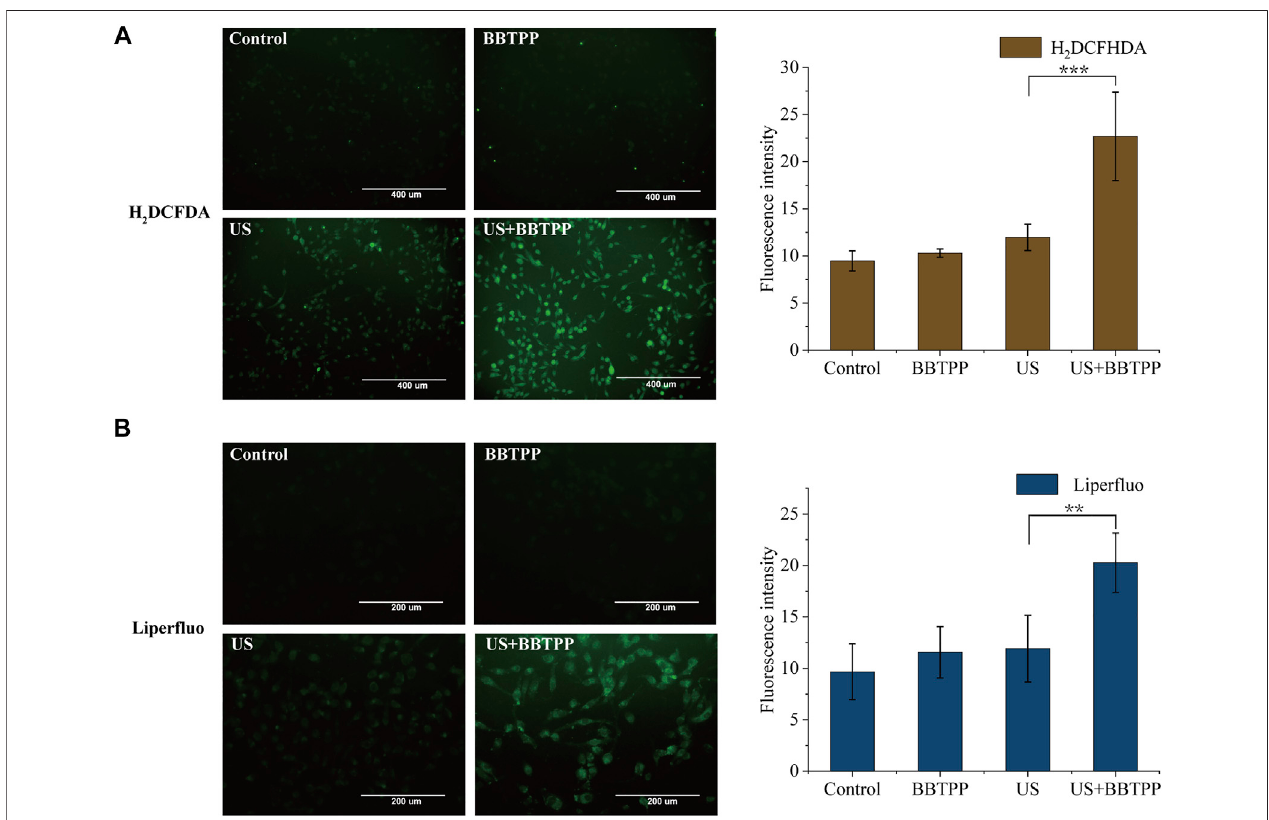
FIGURE 3 | Intracellular ROS production and lipid peroxidation of PC-9 cells under different treatments (A) Representative images of intracellular ROS production measured by H 2 DCFDA and the fl uorescence intensity of H 2 DCFDA analyzed by ImageJ (B) Representative images of lipid peroxidation measured by Liper fl uo and the fl uorescence intensity analyzed by ImageJ. The data were presented as the mean ± standard deviation. US: ultrasound; ** p ＜ 0.01, *** p ＜